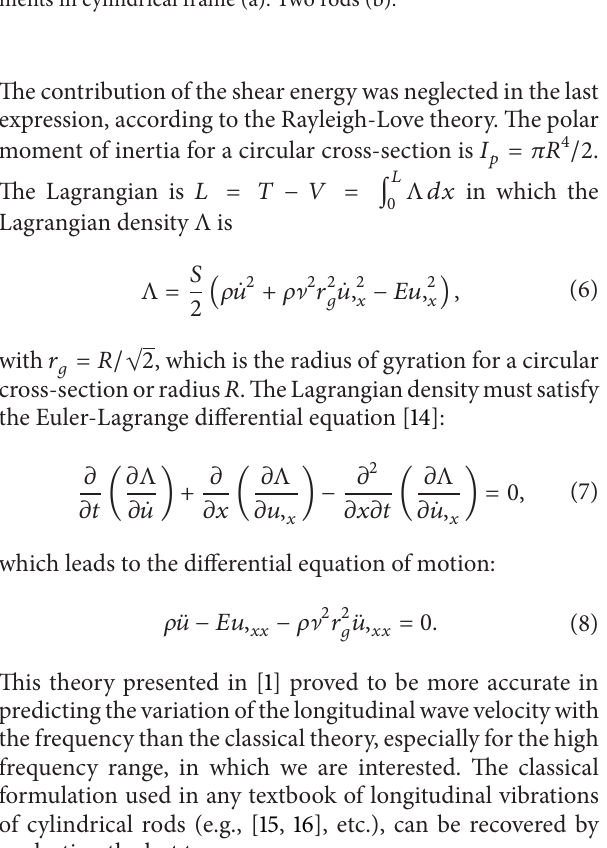
Figure 1: Geometry of the rod with local displacements in cylindrical frame (a). Two rods